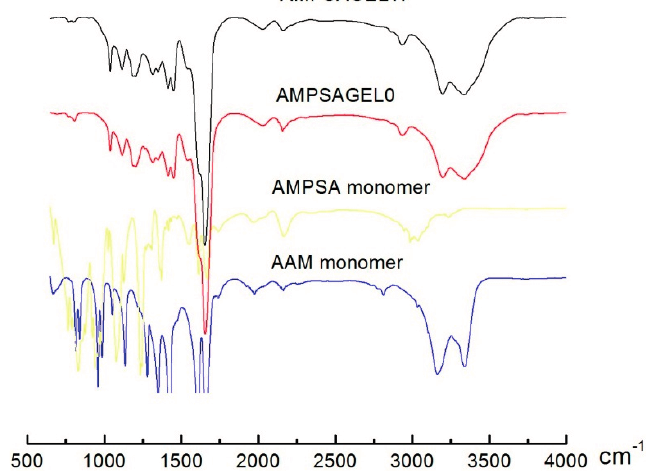
Figure 7. FT-IR of AAm monomer, AMPSA monomer, freezing-dried AMPSAGel0 and